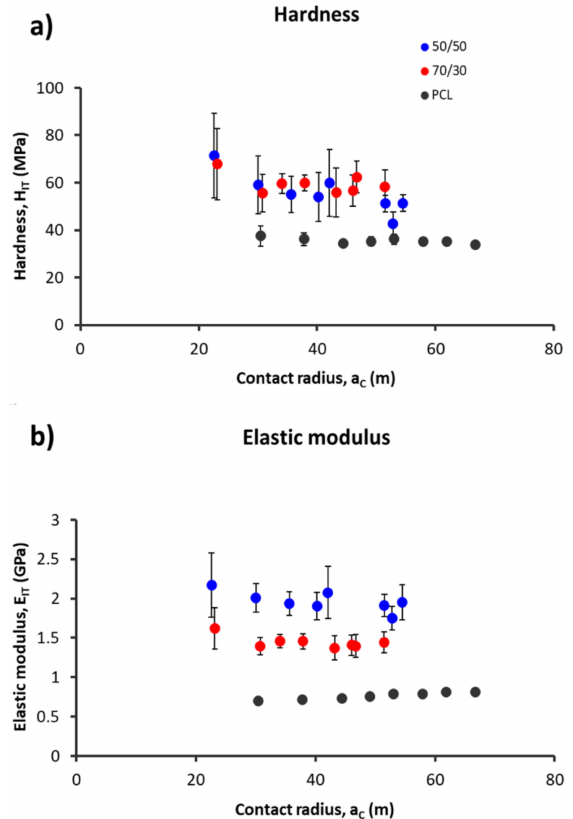
Figure 6. ( a ) Hardness (H) and ( b ) elastic modulus (E) data as a function of contact radius (a C ) for the monolayer composites of 70/30 (blue dots) and 50/50 (red dots) and for the PCL control (black dots). Mean ± SD, n =